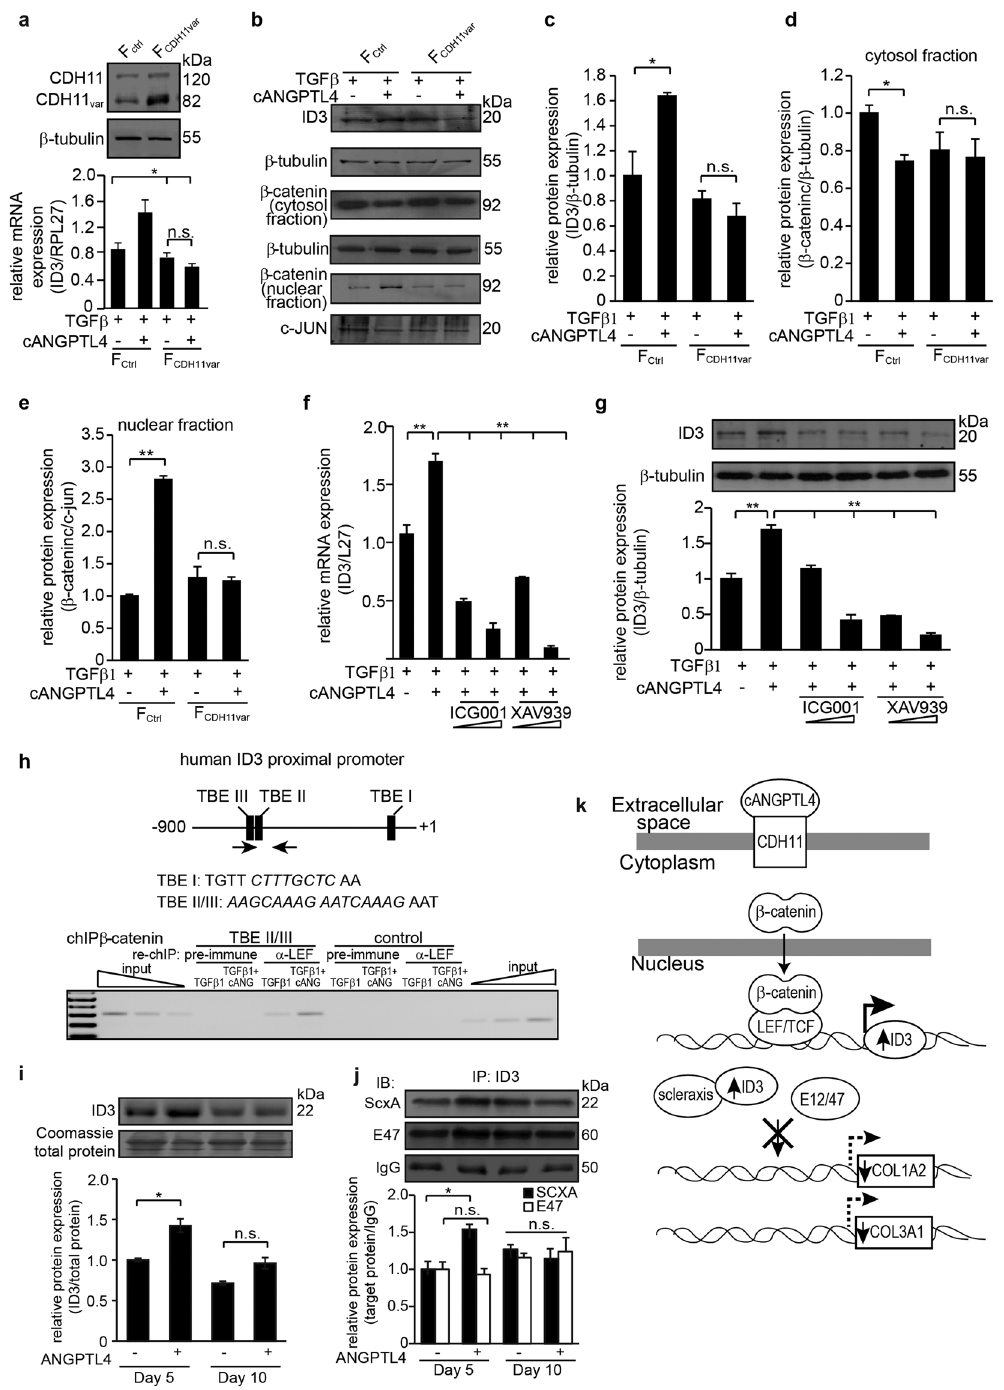
Figure 5. cANGPTL4 upregulates ID3 via a β -catenin-dependent pathway. ( a ) Immunoblot of full-length cadherin-11 (CDH11) and splice variant CDH11 (CDH11 var ) in human fibroblasts. Fibroblasts were transfected with empty vector (F ctrl ) or expression vector containing cDNA encoding CDH11 var (F CDH11var ). β -tubulin, as loading control, was from the same samples. Relative mRNA expression of ID3 in fibroblasts subjected to the indicated treatments. ( b–e ) Immunodetection and quantification of ID3 or β -catenin proteins in fibroblasts subjected to the indicated treatments. β -tubulin (cytosol) and c-JUN (nuclear) from the same samples were used as loading controls. Immunoblot images are cropped; full-length immunoblots can be found in Supplementary Fig. S4h–n. ( f , g ) Relative mRNA and protein expression of ID3 in fibroblasts treated with ICG001 and XAV939, two inhibitors of β -catenin downstream signaling. Ribosomal protein L27 was used as housekeeping control for qPCR. β -tubulin from the same samples was used as loading control for immunoblots. Values represent mean ± SD, n = 5 independent experiments. n.s., not significant, * P < 0.05, ** P < 0.01, *** P < 0.001 (Mann- Whitney U-test). ( h ) ChIP of TBE on the human ID3 gene using anti- β -catenin antibody followed by